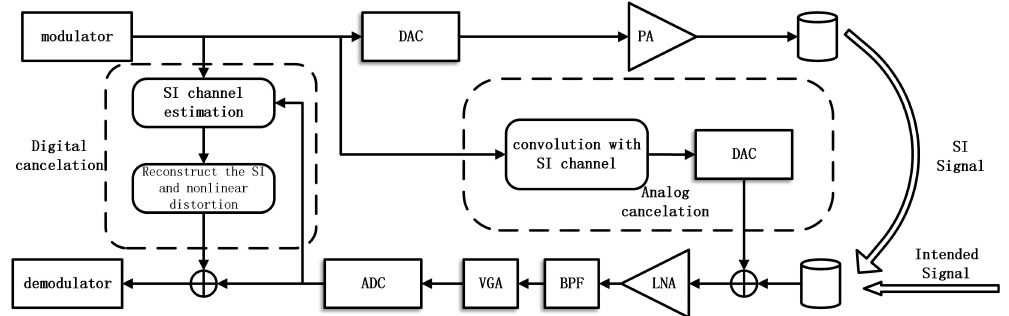
Figure 1. Structure of IBFD-UWA communication